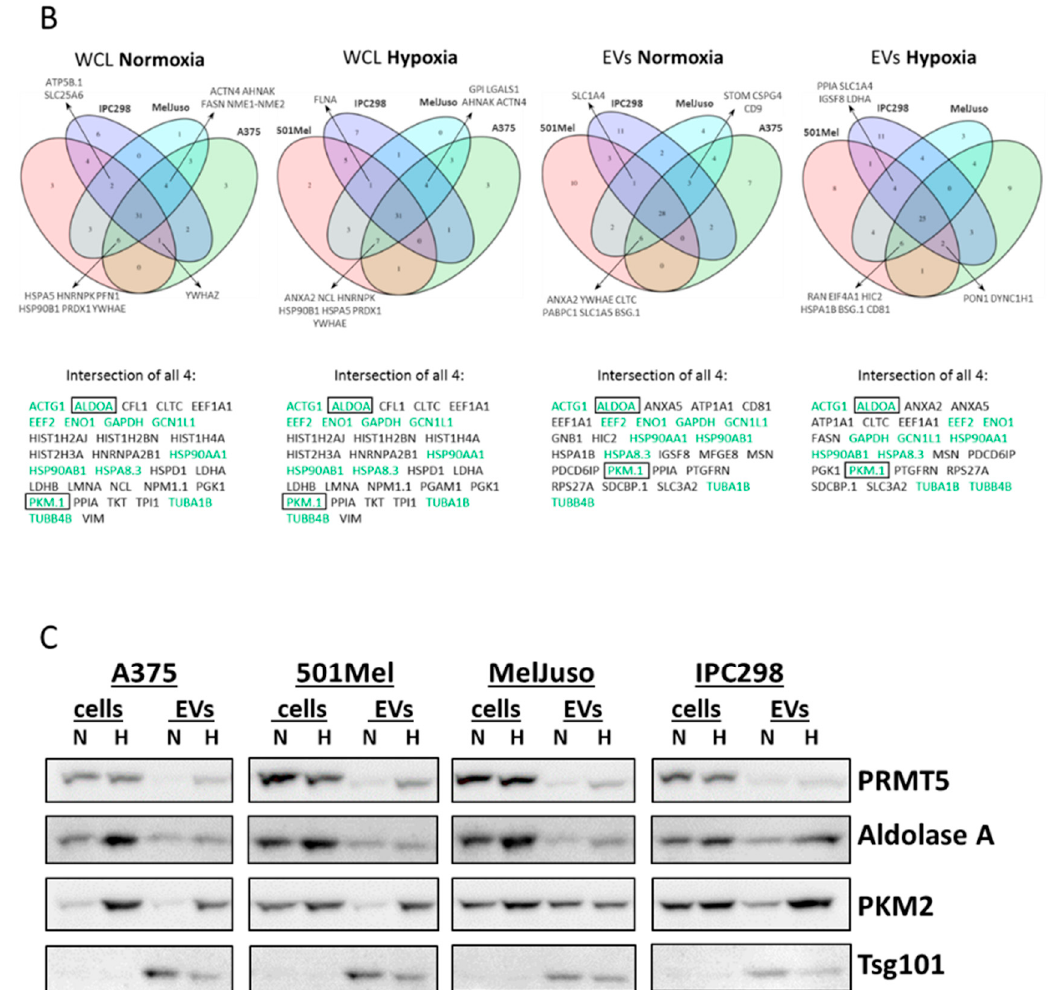
Figure 3. Proteomic analysis of nEVs and hEVs, normoxic and hypoxic whole cells lysates (WCLs) of melanoma cells. ( A ) Heatmap showing the proteins differentially expressed between normoxia and hypoxia in at least two cell lines, either in EVs or in WCLs, and not imputed in this compartment (either EVs or WCLs). Using these criteria, 49 proteins were identified in EVs, and 14 proteins were identified in WCL. Colour shows normalised expression. Three biological replicates were used for the melanoma cell lines (A375, 501Mel, IPC298), and only two biological replicates for the melanoma cell line MelJuso due to technical problems. ( B ) Venn diagrams showing the intersections of the top 50 expressed proteins for the four melanoma cell lines in WCL or EV under normoxia or hypoxia. The common proteins for the four melanoma cell lines are indicated below the Venn diagrams. Common proteins for all groups are written in green. Black boxes indicate proteins further validated by Western blot. ( C ) Expression analysis of ALDOA, PKM2, PRMT5, Tsg101 (EV marker) in normoxic or hypoxic WCL and nEVs or hEVs of four melanoma cell lines (A375, MelJuso, IPC298, 501Mel) by Western blot.